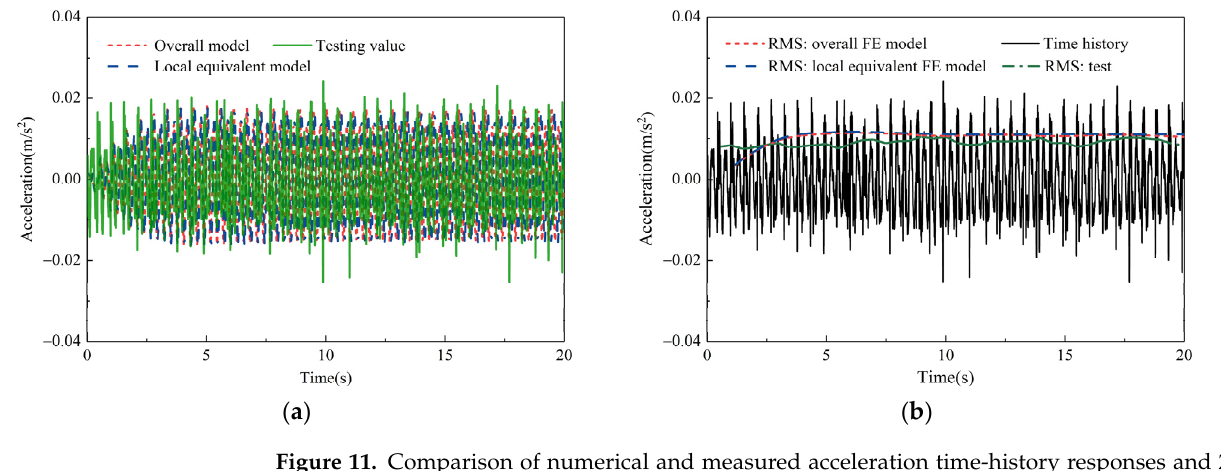
Figure 11. Comparison of numerical and measured acceleration time-history responses and 20 s RMS acceleration of the suspended floor under case WP-1: ( a ) acceleration time-history responses; ( b ) RMS acceleration.